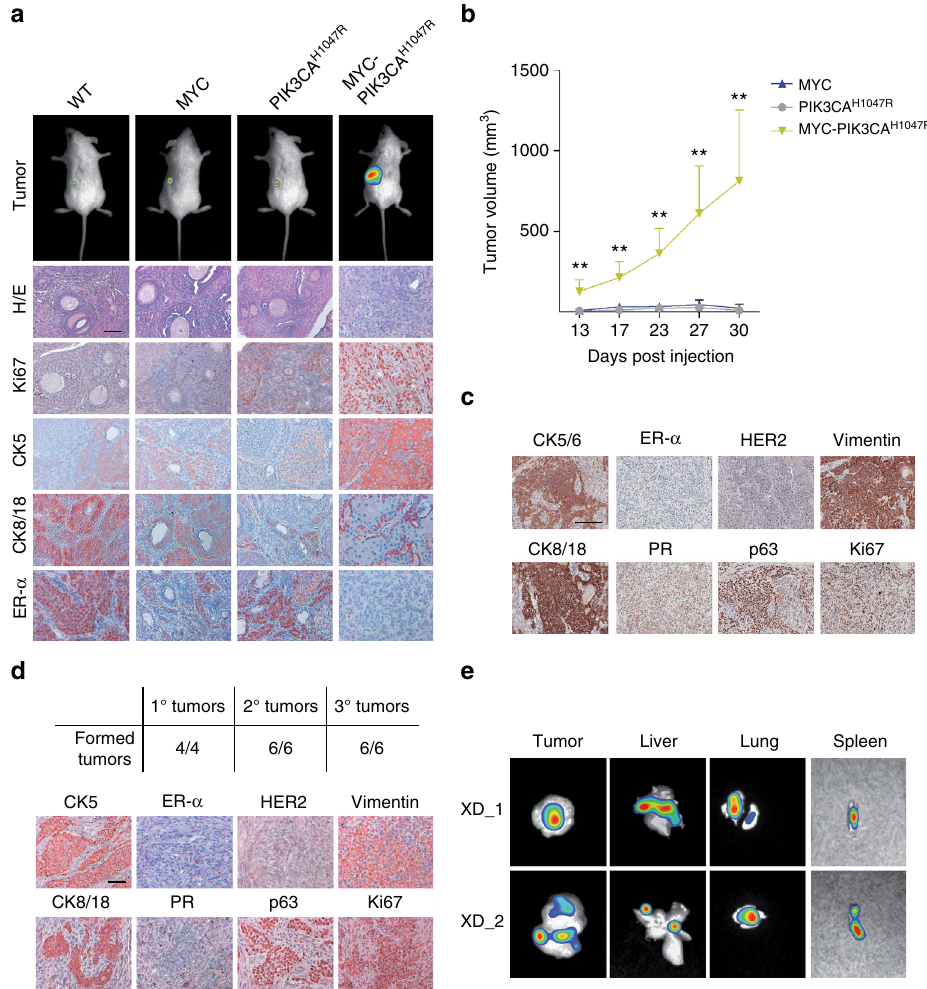
Fig. 6 MYC-induced reprogramming favors the onset of TICs. a In the upper panel, whole body imaging of NOD/SCID mice 6 weeks after injection into the sub-renal capsule of indicated cells ( n = 3). In the lower panel, representative hematoxylin & eosin (H/E) and immunohistochemical staining for indicated markers on generated xenografts. Scale bar, 50 μ m. b Primary xenograft tumor volume (mm 3 ) following orthotopic injection of indicated cells in NOD/ SCID mice. Data are mean tumor size ± SEM ( n = 4) (** P < 0.01; Student ’ s t- test; IMEC-MYC-PIK3CA H1047R compared with IMEC-MYC). c Representative immunohistochemical staining of indicated markers on primary tumors generated after orthotopic injection of IMEC-MYC-PIK3CA H1047R in NOD/SCID mice ( n = 4). d In the upper panel, table depicting the number of formed tumors per injected mice in a serial transplantation assay. In the lower panel, representative immunohistochemical staining of indicated markers performed on tertiary tumors. Scale bar, 50 μ m. e In vivo imaging of metastasis generated in NOD/SCID mice 4 weeks after secondary tumor removal. Representative images of two mice are shown ( n =